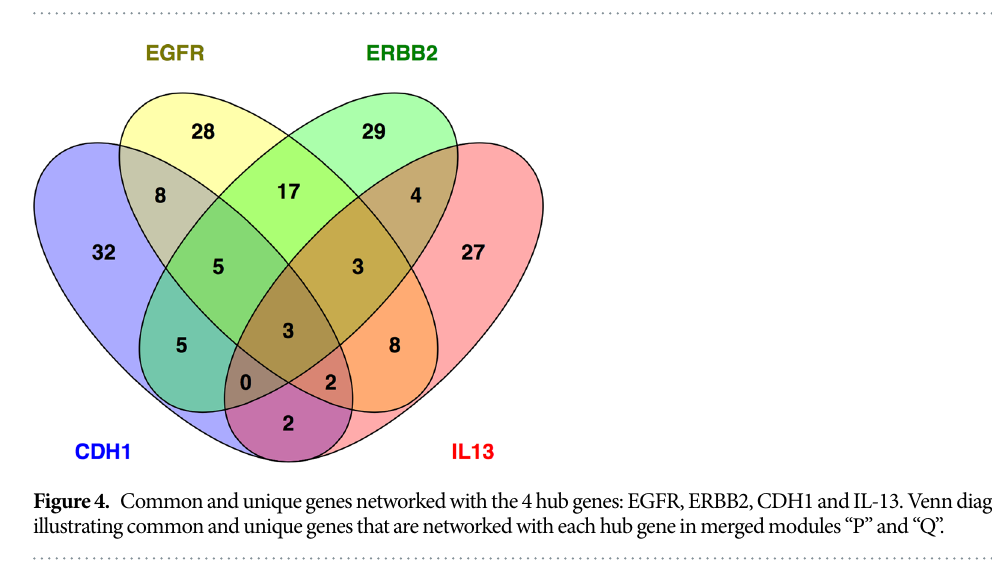
and ERBB2 for validation because these were the dominant hubs in the other modules. These studies focused on